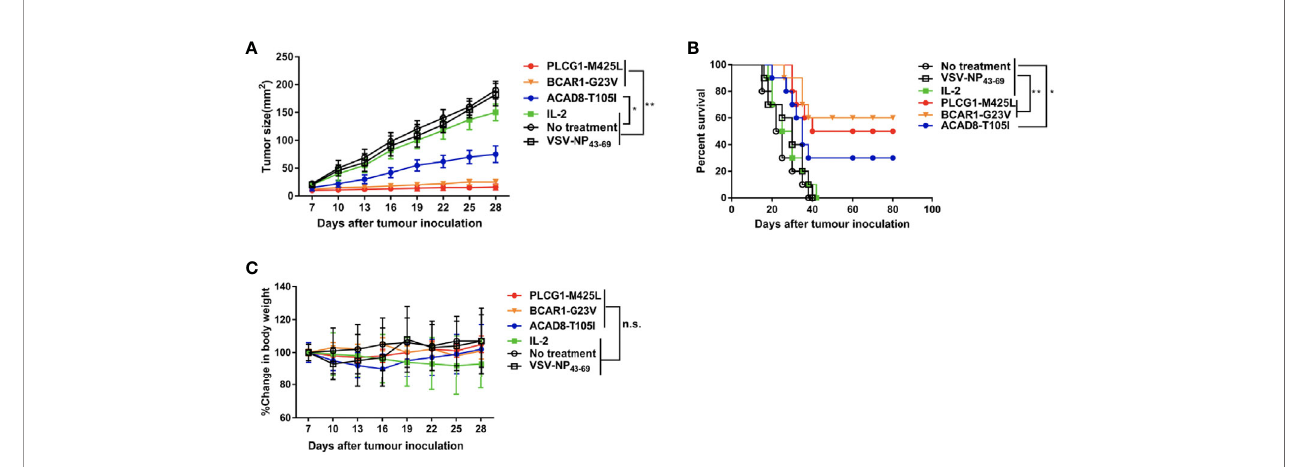
FIGURE 5 | Adoptive immunotherapy of minigene-nucleofectedH522/Kb tumor-bearing nude mice. Minigene-nucleofected H522/Kb tumor cells (5 × 10 6 cells/ mouse) were injected into the fl anks of C57BL/6 nu/nu mice. Three days later, splenocytes (1×10 8 cells/mouse) from ACAD8-T105I-, BCAR1-G23V- or PLCG1- M425L-immunized HLA-A2.1/K b Tg mice were injected as described in the Materials and methods section. The mice in the control groups received IL-2 alone or did not receive treatment. (A) Tumor growth was observed every 3 days and recorded as the mean tumor size (mm 2). (B) Survival of mice after tumor inoculation (n = 10 mice/group). (C) The effect of different treatments on mouse body weight. (* P <0.05; ** P